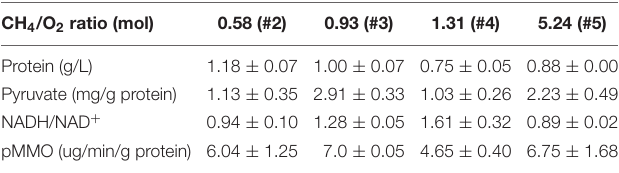
TABLE 1 | Quantification of the amount of total protein, pyruvate, NADH, and MMO activity under different CH 4 /O 2 ratio conditions at time point 24 h post